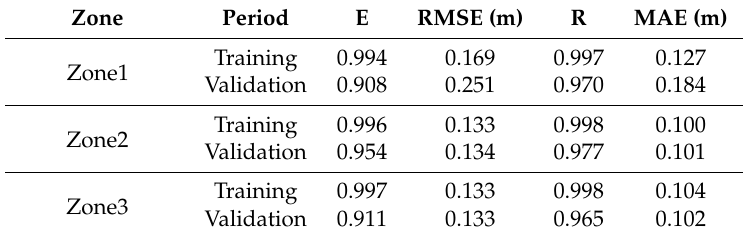
Table 2. Statistical indicators of FNN Model 1 performance during training and validation period.